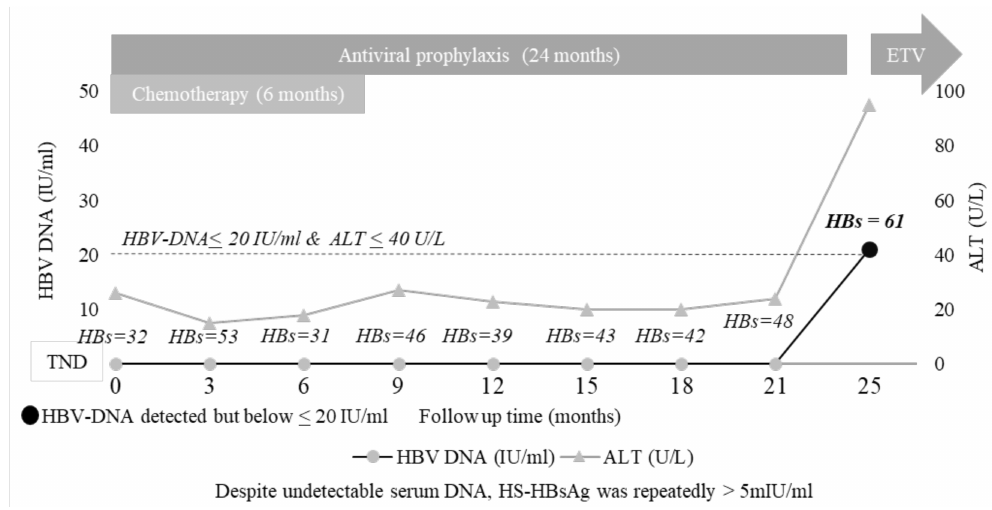
Figure 3. A clinical case shows the quantified persistence of high-sensitivity